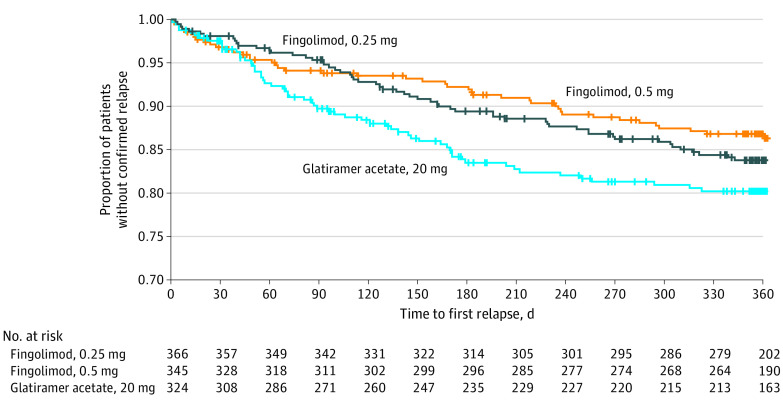
Time to First Confirmed Relapse Through Month 12 for Full Analysis Set